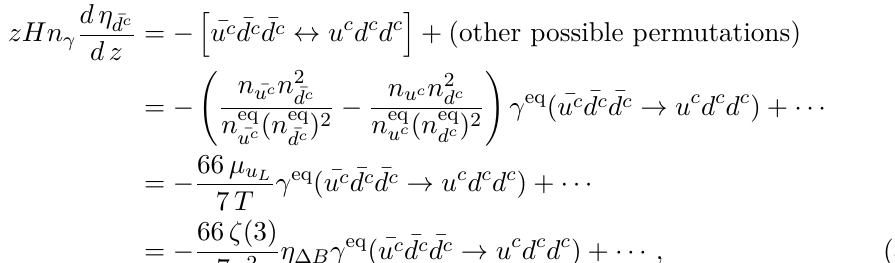
Figure 2 . Left: ratio between the width of the interaction induced by operator O 1 and the Hubble rate H , as a function of temperature T . When this fraction is greater than 1, as indicated by shaded areas, the interaction is assumed to provide a strong washout of baryon asymmetry. Right: temperature at which the fraction Γ falls below 1 (purple), and a more accurate limit on the W /H out-of-equilibrium temperature coming from eq. (3.18) (green). In blue and orange shaded areas, the experimental reach of the LHC and different n - ¯ n experiments are shown, respectively. species abundance;